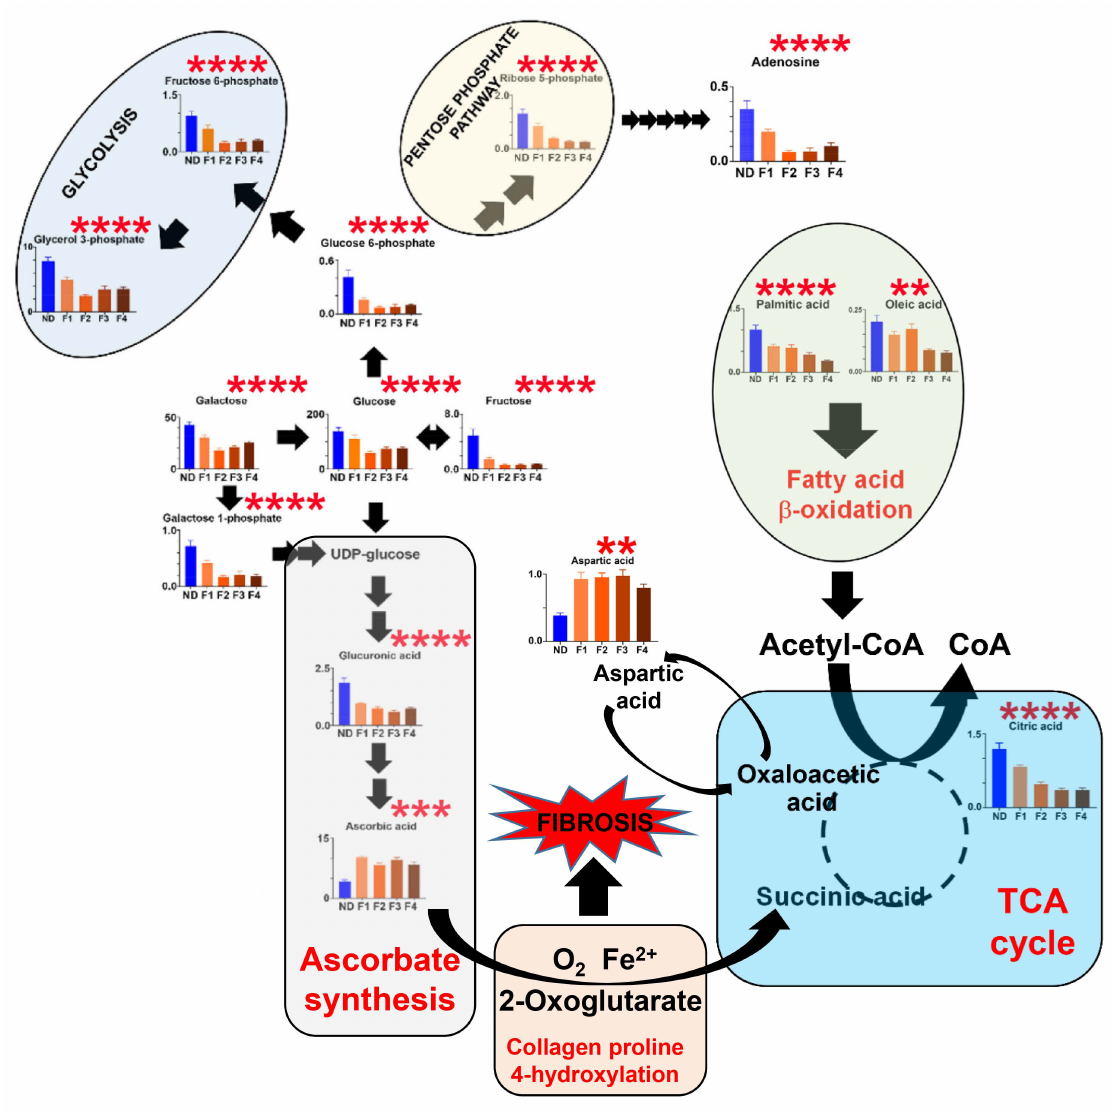
Figure 5. The appropriation of glucose metabolism for ascorbate synthesis in the livers of mice admin- istered choline-deficient, amino-acid-defined diets with high fat content ** = p < 0.01; *** = p < 0.001; **** = p <